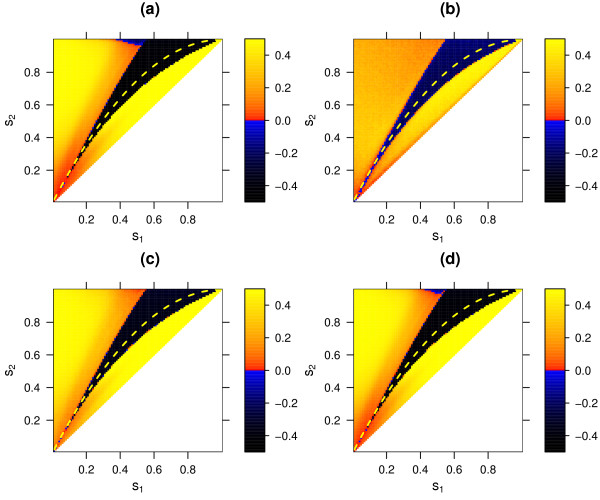
Selective advantage of sexual over asexual reproduction (rmm = 0, rmM = 0, rMM = 0.1) in the standard model for different interaction matrices, simulated deterministically (a) and stochastically with populations sizes N = 1000 (b), N = 10 000 (c), and N = 100 000 (d). The color of each of the points on a graph shows the frequency change during a simulation run (i.e. 1000 host generations after introduction of the modifier allele M), averaged over 10000 simulation runs (100 for the deterministic model) with different random initial conditions. The number of host alleles, n, matched by the parasite determines the corresponding fitness wn in the following way: for hosts, w2 = 1-s2, w1 = 1 - s1, w0 = 1, for parasites w2 = 1, w1 = (1 - s2)/(1 - s1), w0 = 1 - s2. This generalized model reflects the biological characteristic that host and parasite fitness are inversely correlated. The matrix can be continually varied as a function of the parameters s1 and s2, and contains the MA and the MMA as special cases (MA: s1 = 0; MMA, s2 = 1-(1-s1)2, yellow dashed line). Only fitness matrices with s1 ≦ s2 are shown. The parameters s1 and s2 range from 0 to 1 with 0.01 gradation.